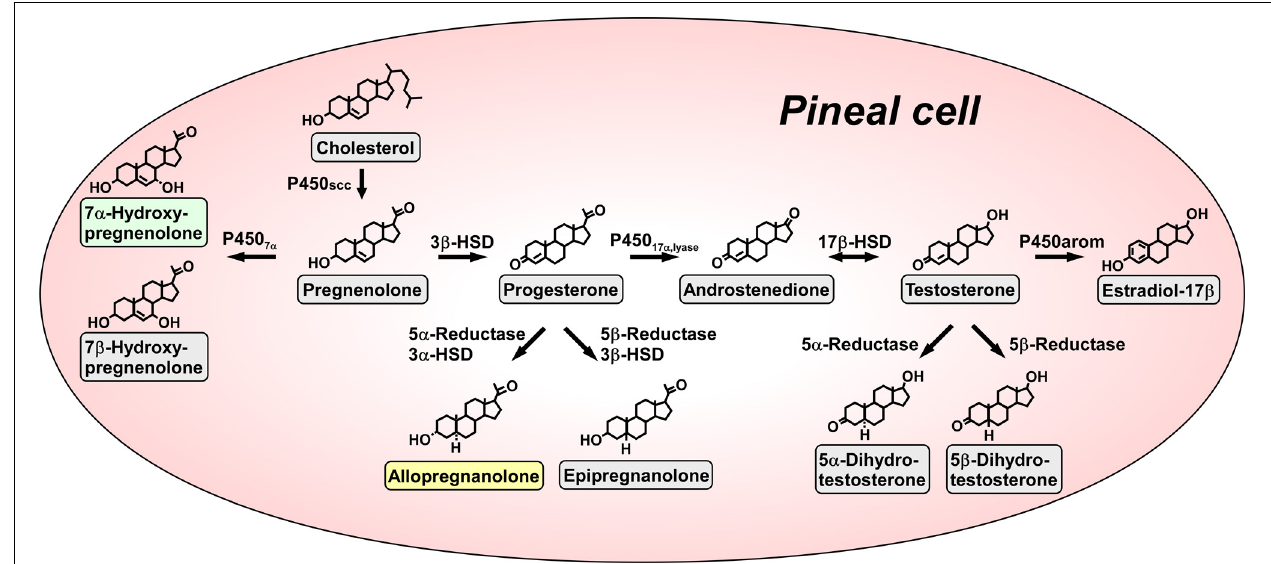
FIGURE 1 | Biosynthetic pathways for neurosteroids in the pineal gland. The arrows indicate the biosynthetic pathways of neurosteroids identified in the pineal glands of juvenile quail. The pineal gland actively produces a variety of neurosteroids de novo from cholesterol. Allopregnanolone and 7 α -hydroxypregnenolone are major products secreted by the pineal gland. P450scc, cytochrome P450 side-chain cleavage enzyme (gene name Cyp11a